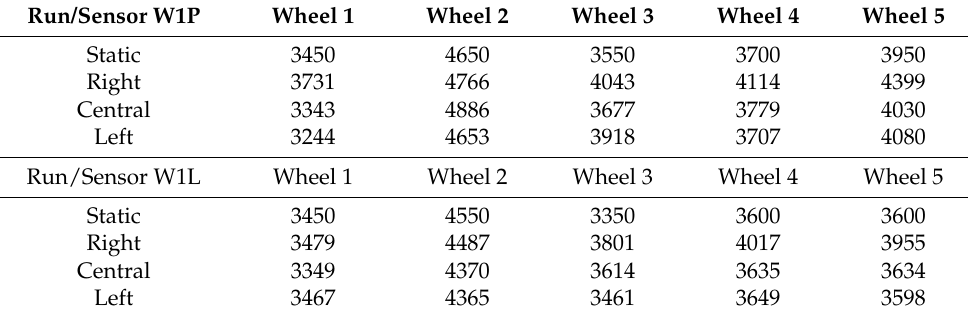
Table 5. Strain gauge sensor signal characteristics and reference static measurements—wheel load (kg).